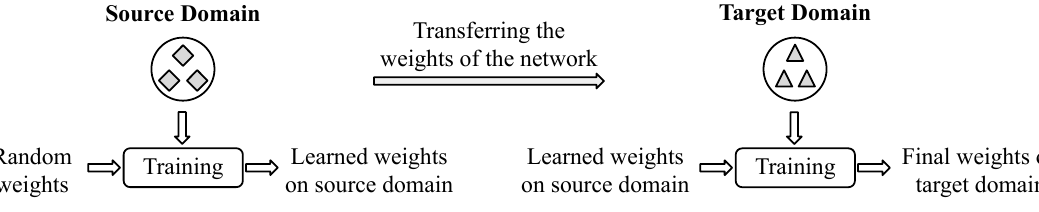
Figure 2. Parameter-based transfer learning method (weight